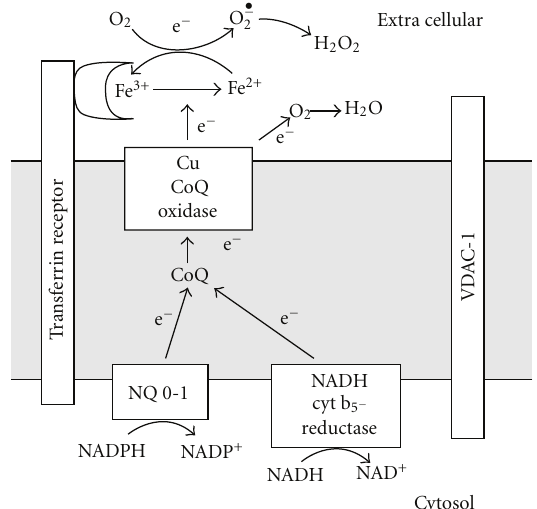
Figure 1: Diagram of plasma membrane redox involved in ferric transferrin reduction [15, 37,